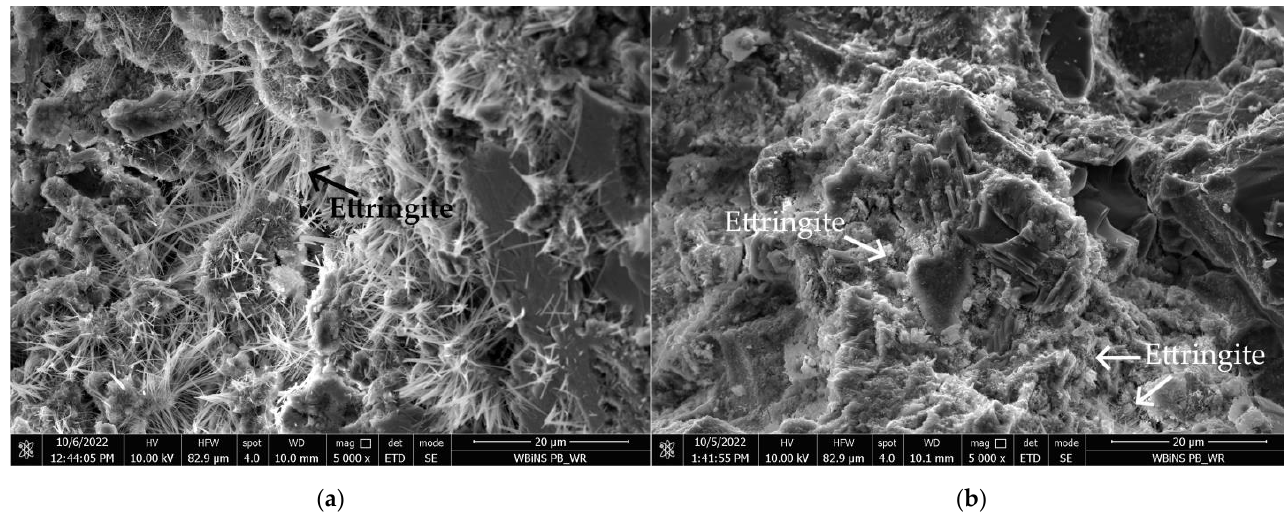
Figure 13. SEM photographs showing the ettringite structure of cement mortar with a 25% addition of (a) untreated fly ash (FA(B)N) and (b) fly ash sieved with 63 µm sieve (FA(B)63).